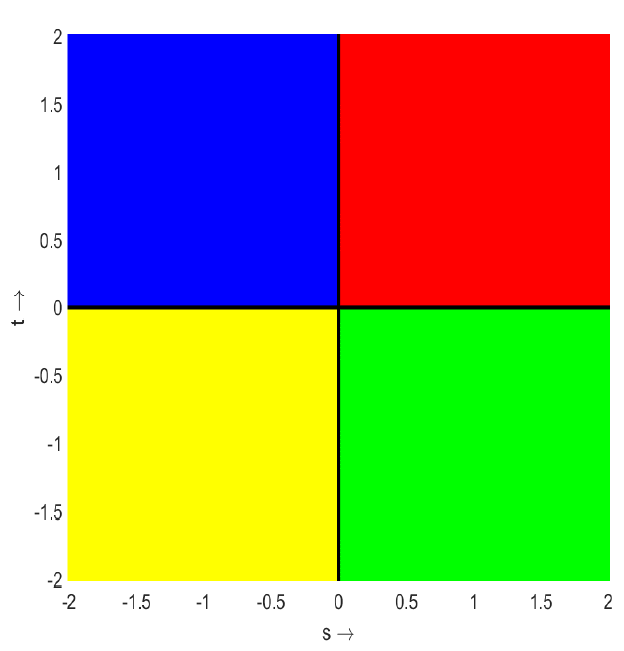
Figure 7. Dynamics of the method (2) associated with BA of Example